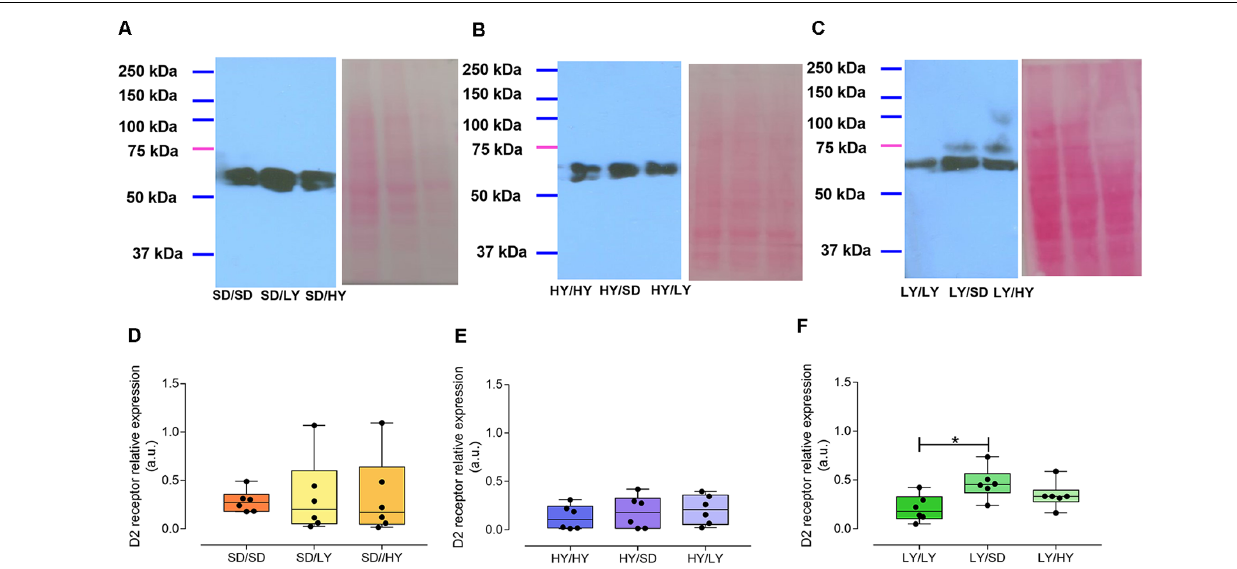
FIGURE 8 | Relative expression of the D 2 receptor (DR2) in the striatum of rats of both sublines and of SD male rats raised by different dams. Representative immunoblots from the striatal D 2 receptor expression and matched Ponceau’s red staining in (A) SD male rats raised by SD dams (SD/SD), or by LY (SD/LY), or HY (SD/HY) male rats; (B) HY, SD, or LY male rats raised by HY dams (HY/HY, HY/LY, and HY/SD); (C) LY, SD, or HY male rats raised by LY dams (LY/LY, LY/SD, and LY/HY, respectively). The D 2 receptor relative expression was normalized against the matching Ponceau’s red stained lane and expressed as arbitrary units. (D–F) Data are shown as the median and interquartile ranges. Only SD male rats raised by LY dams significantly differ from LY/LY group [Kruskal–Wallis analysis of variance (ANOVA), H = 7.4, P < 0.02, followed by Dunn multiple-comparisons test, * P <